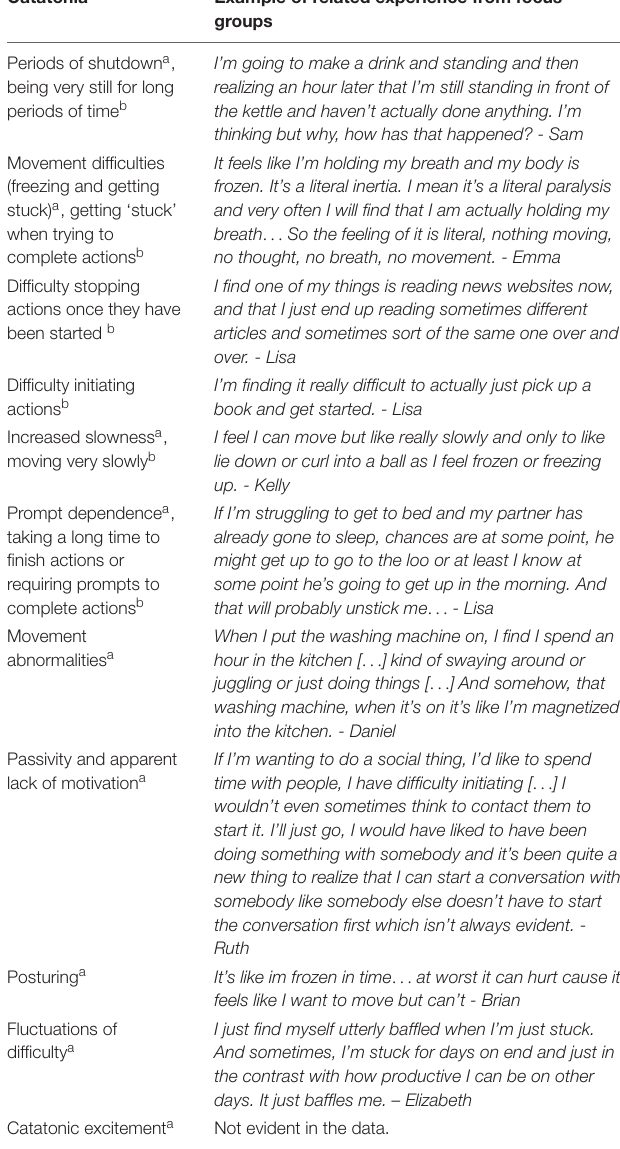
TABLE 3 | Examples of catatonia-like features from participant